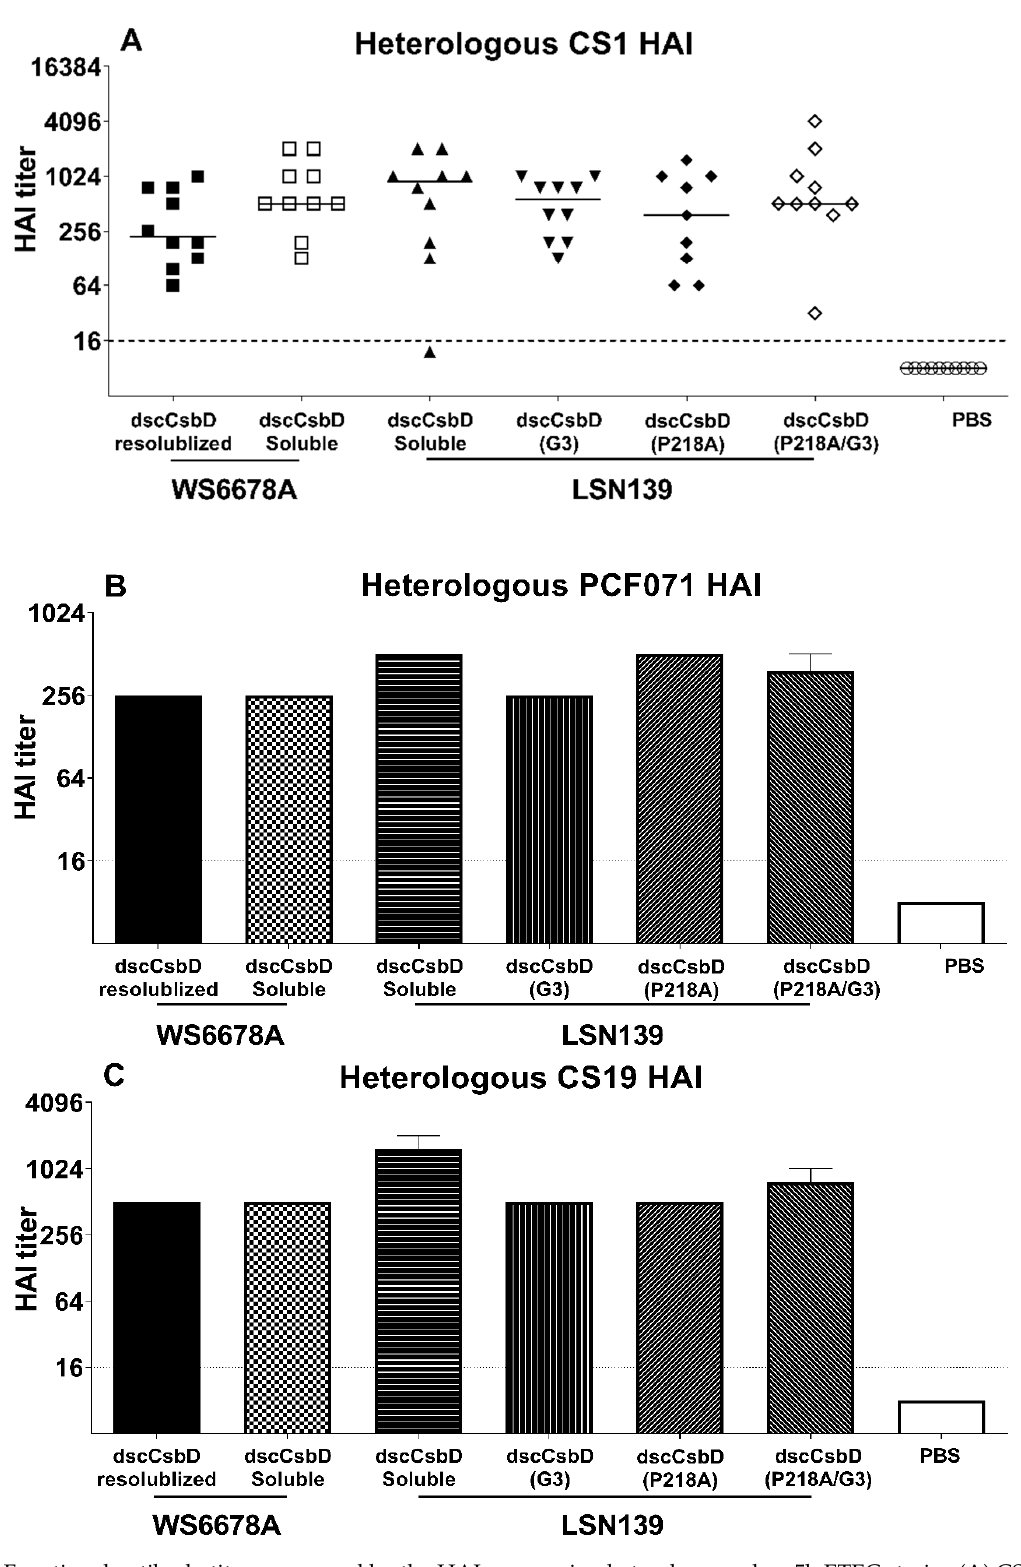
Figure 3. Functional antibody titers measured by the HAI assay using heterologous class 5b ETEC strains ( A ) CS1 + ETEC strain WS1974A, ( B ) PCF071 + ETEC strain WS2173A, ( C ) CS19 + ETEC strain WS0115A. ( A ) Individual values are shown with the median of each group represented by a horizontal solid line. ( B , C ) HAI titers of pooled samples are shown as bars. Horizontal dotted lines denote the lowest dilution tested for the assays (1:16).